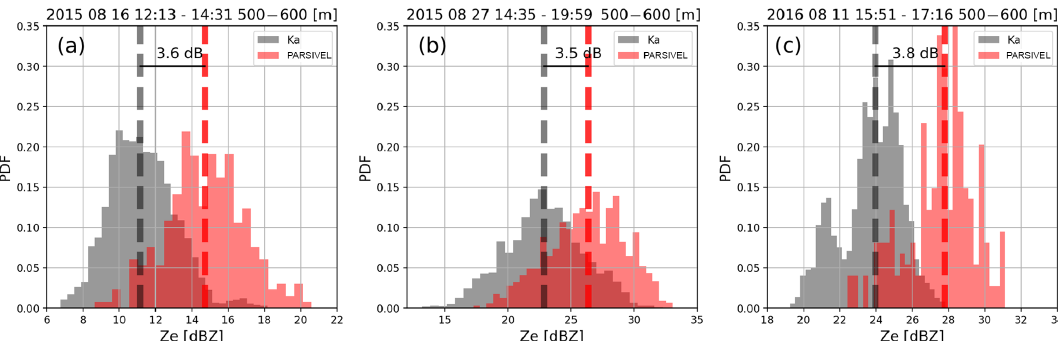
Figure 3. Histograms of radar reflectivities from the Ka band (gray) and results from T-matrix calculations with the raindrop size distribu- tion provided by PARSIVEL (red) for three long-lasting stratiform rain cases before and after the TRIPEx campaign ( a 16 August 2015, b 27 August 2015, c 11 August 2016). Ka band reflectivities are taken from the lowest clutter-free range gates between 500 and 600m. The vertical dashed line indicates the median of the distribution; the offset is calculated as the difference between Ka band and T-matrix results.